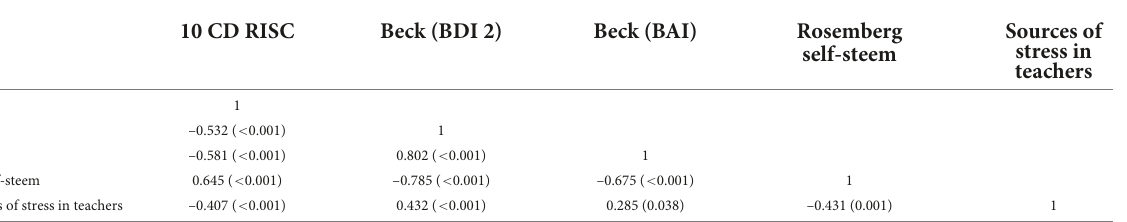
TABLE 3 Correlation and differences between